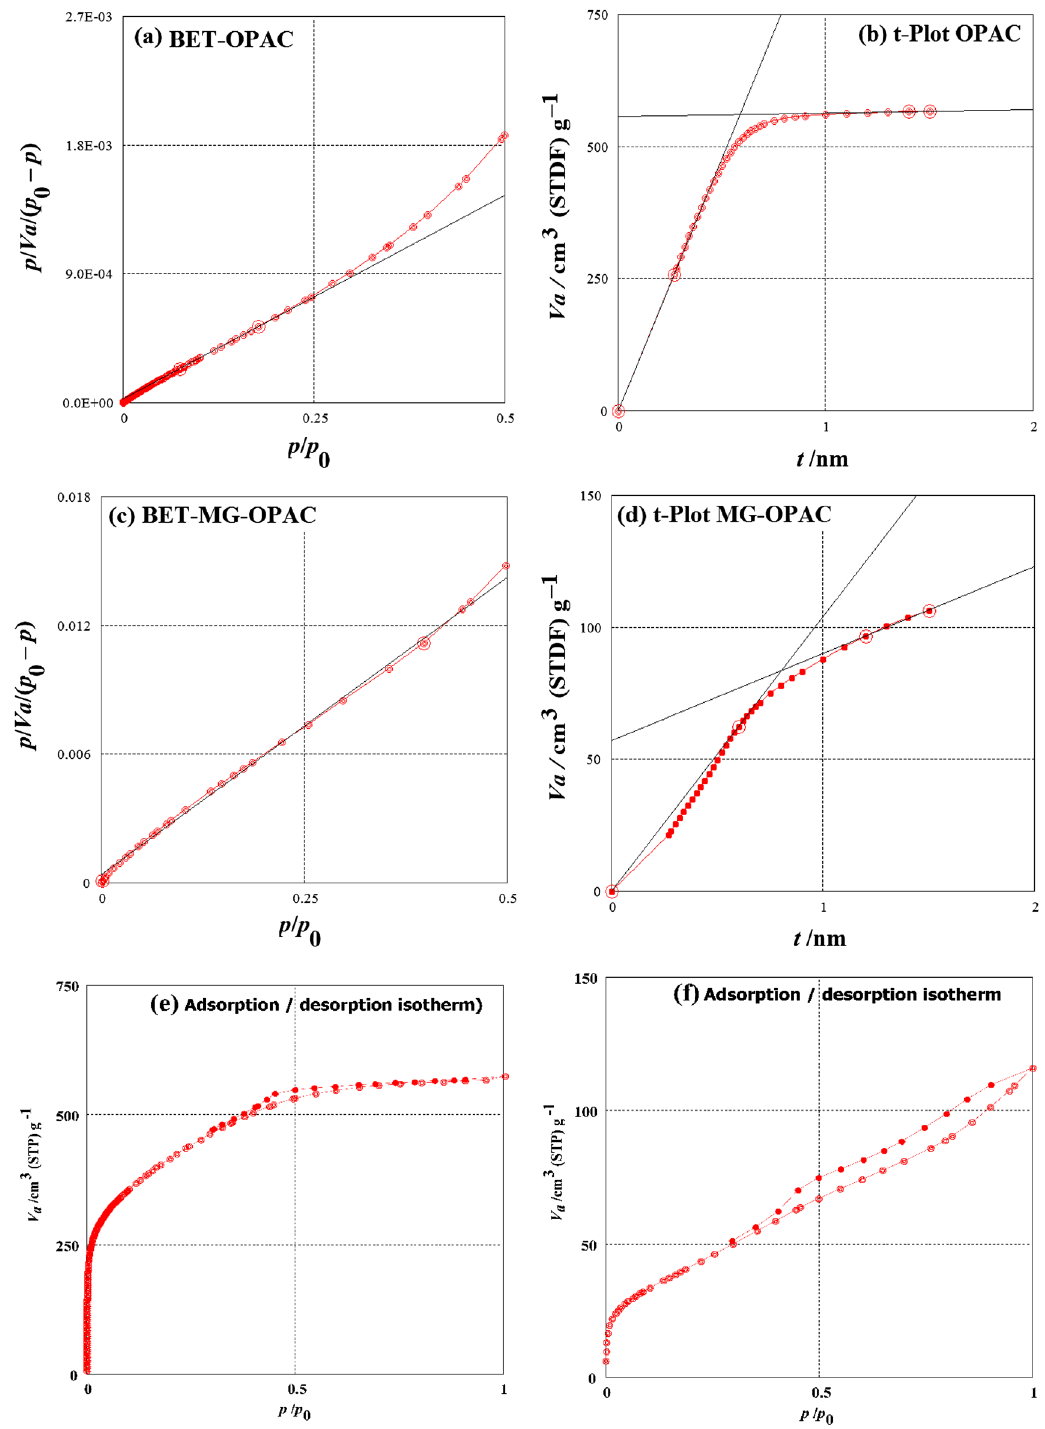
Figure 1. ( a ) BET surface area curve of OPAC, ( b ) t-Plot surface area curve of OPAC, ( c ) BET surface area curve of MG-OPAC, ( d ) t-Plot surface area curve of MG-OPAC, ( e ) Adsorption–desorption isotherm of